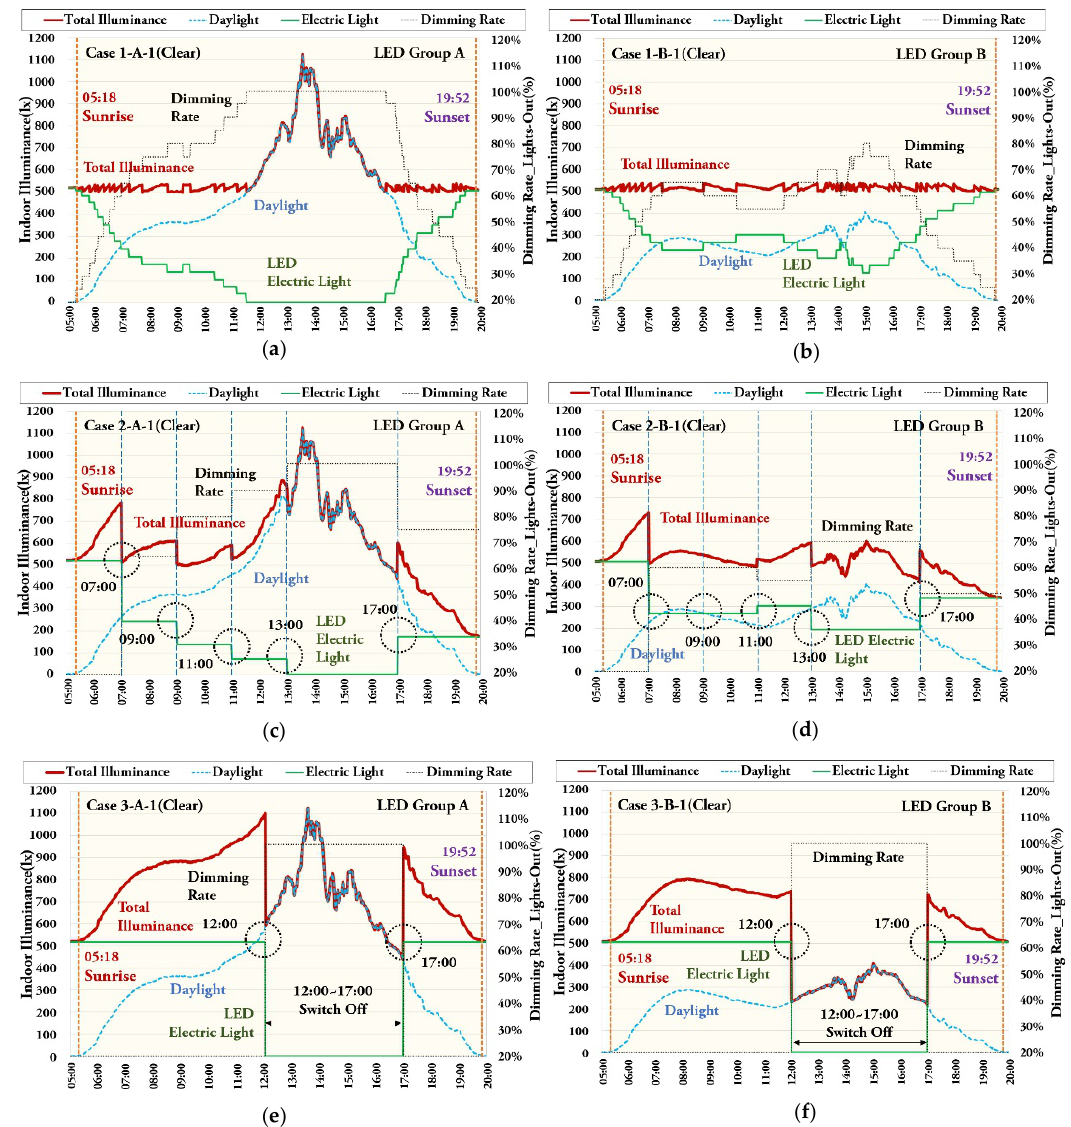
Figure 12. Illuminance and dimming rate under dimming control with no blinds (clear sky_07.16). ( a ) Case 1-A-1, ( b ) Case 1-B-1, ( c ) Case 2-A-1, ( d ) Case 2-B-1, ( e ) Case 3-A-1, and ( f ) Case 3-B-1 in Table 5.